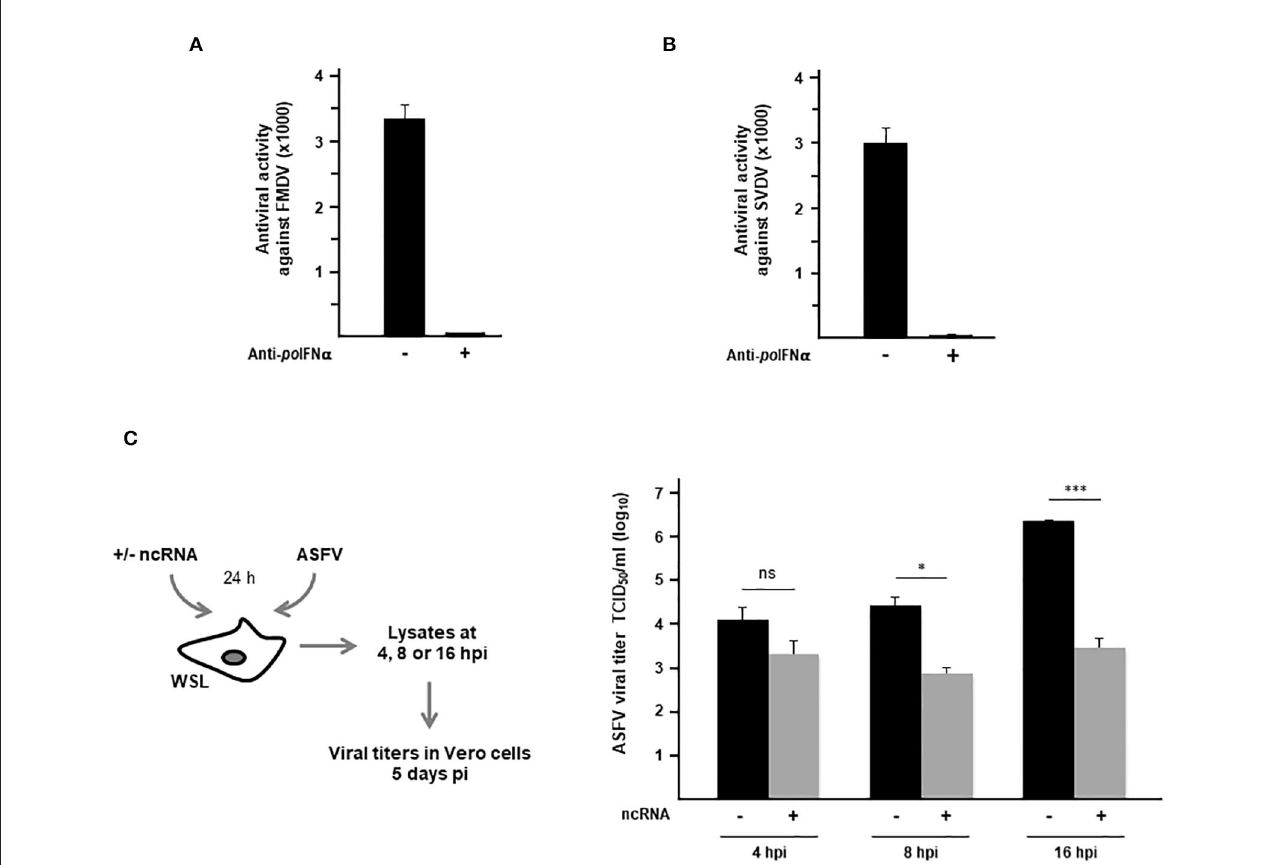
FIGURE 3 | Antiviral activity against FMDV, SVDV and ASFV induced in WSL cells by transfection with the ncRNAs. (A,B) Supernatants from WSL cells transfected with IRES RNA for 24h were assayed on fresh WSL monolayers against infection with FMDV (A) or on IBRS2 cells against infection with SVDV (B) . Where indicated, supernatants were incubated previously with antibodies against swine IFN- α . Antiviral activity was expressed as the reciprocal of the highest supernatant dilution needed to reduce the number of FMDV plaques by 50%. Data are mean ± SD of triplicates. (C) WSL cells were transfected with IRES transcripts or mock-transfected and 24h later infected with ASFV at an MOI of 2. Lysates were collected at 4, 8 or 16h after infection and viral titers were determined in Vero cells after 5 days of infection. Data are average of triplicates ± SD (* p < 0.05; *** p < 0.001; ns, not